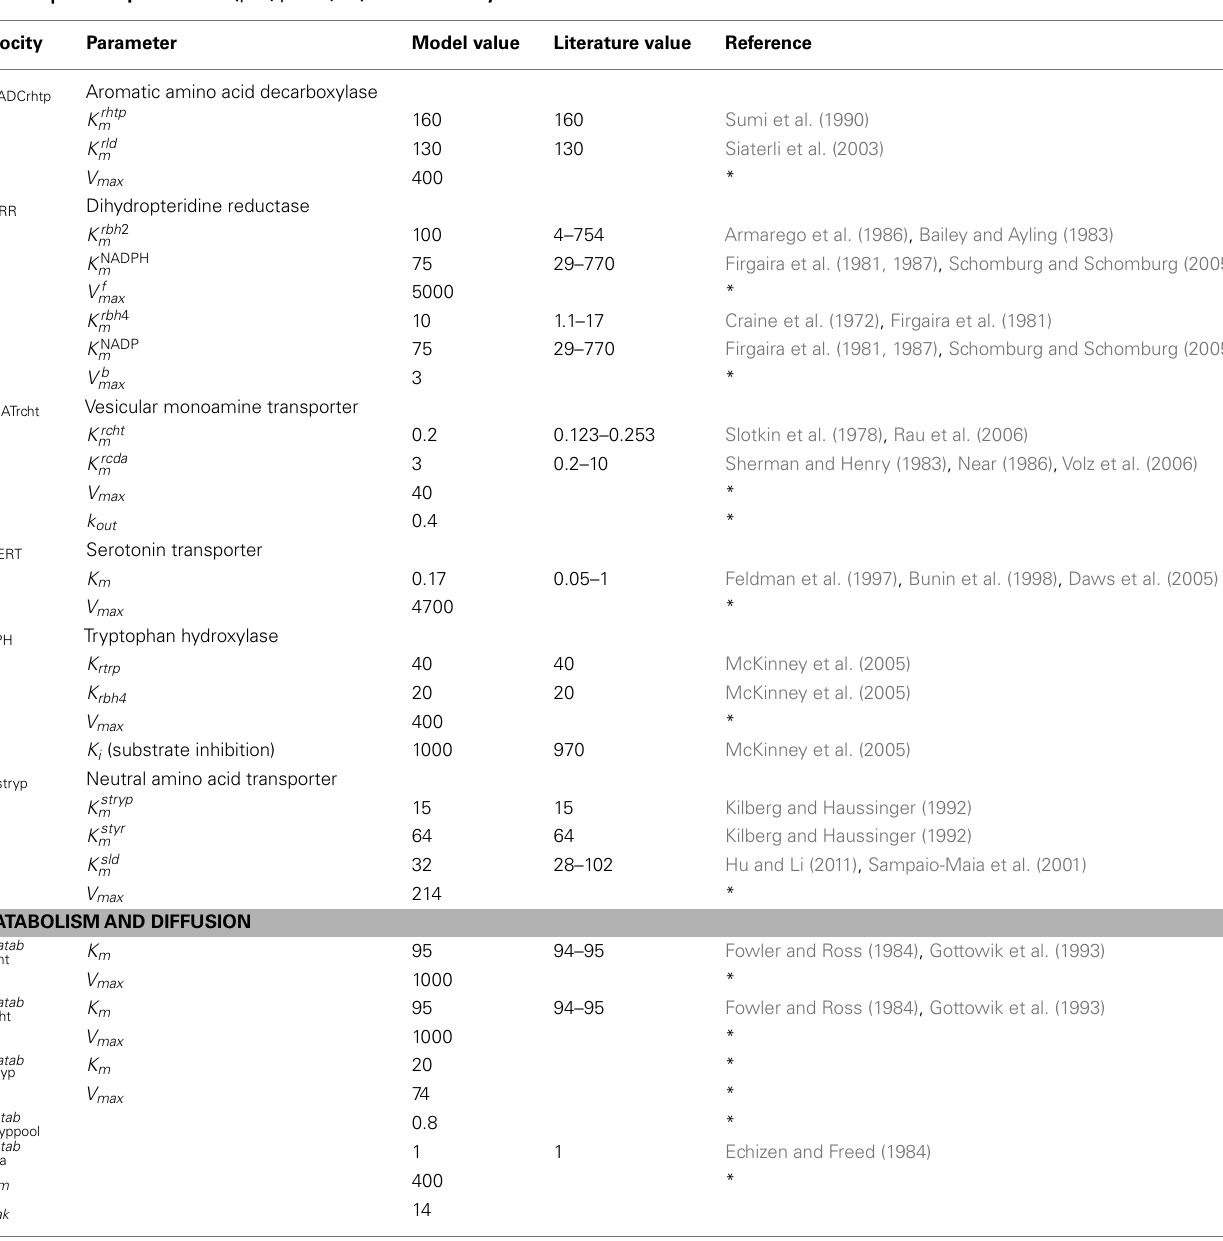
TableA3 | Kinetic parameters ( µ M, µ M/h, /h): 5HT cell